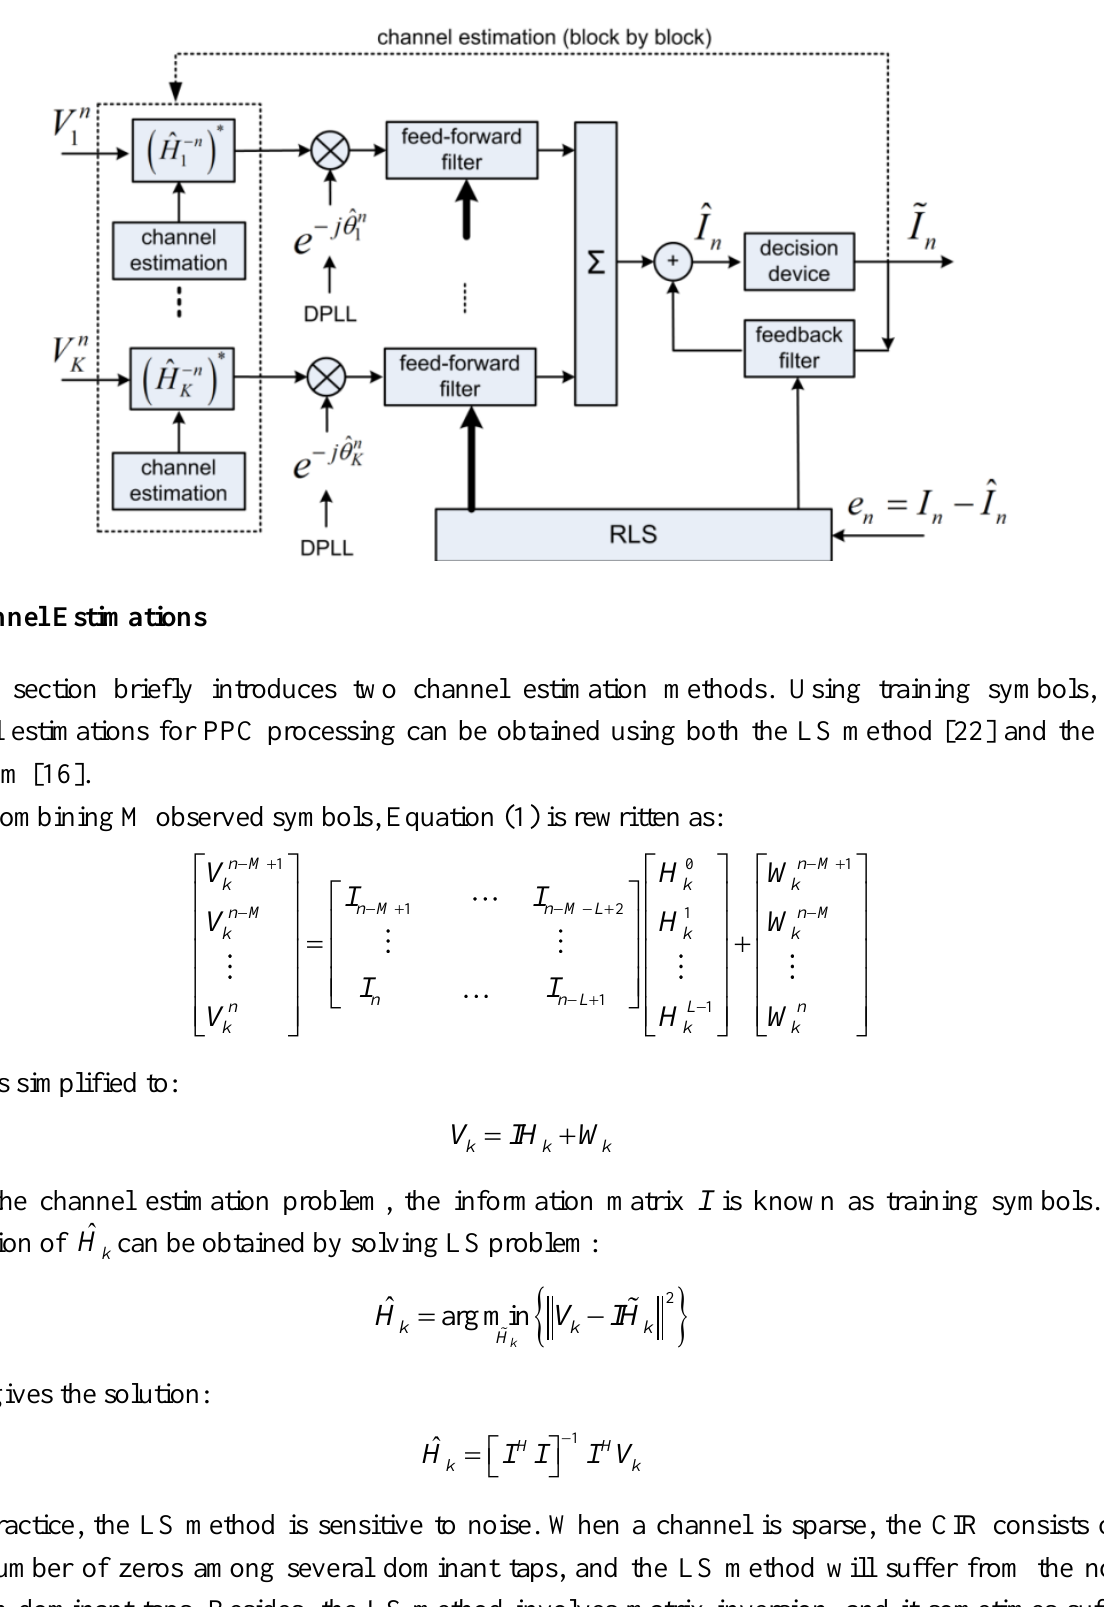
Figure 7. Block diagram of